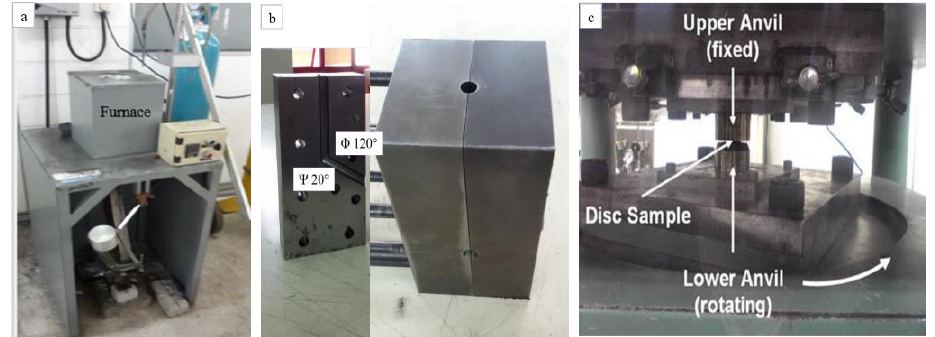
Figure 1. Schematic of ( a ) cooling slope casting, ( b ) ECAP die, and ( c ) HPT facility.